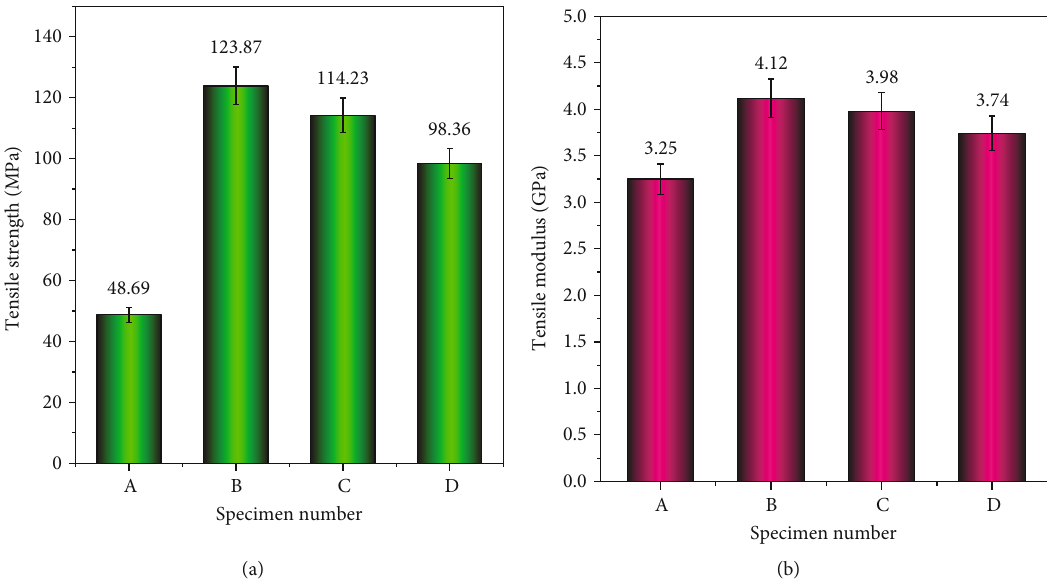
Figure 5: Kevlar and hemp-based hybrid composites: (a) tension behavior and (b) tension modulus.